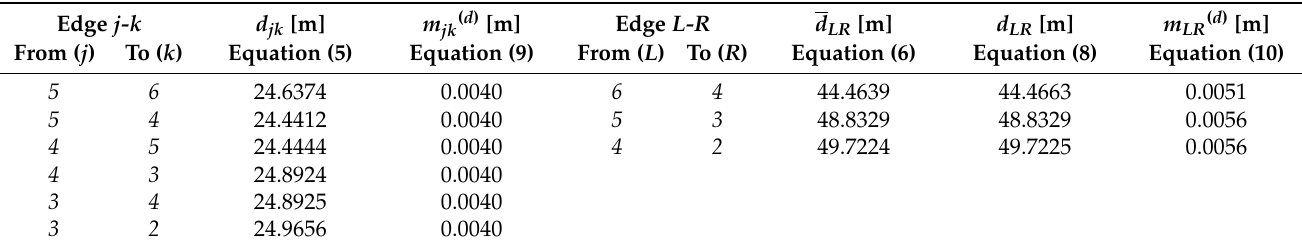
Table 4. Linear pseudo-observations of types j-k (5) and L-R (8) and their mean errors (9) (10). Edge j-k d jk